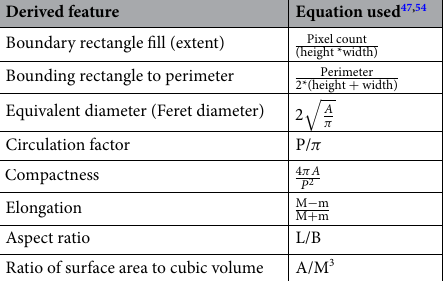
Table 2. Size and shape derived features from image analysis.